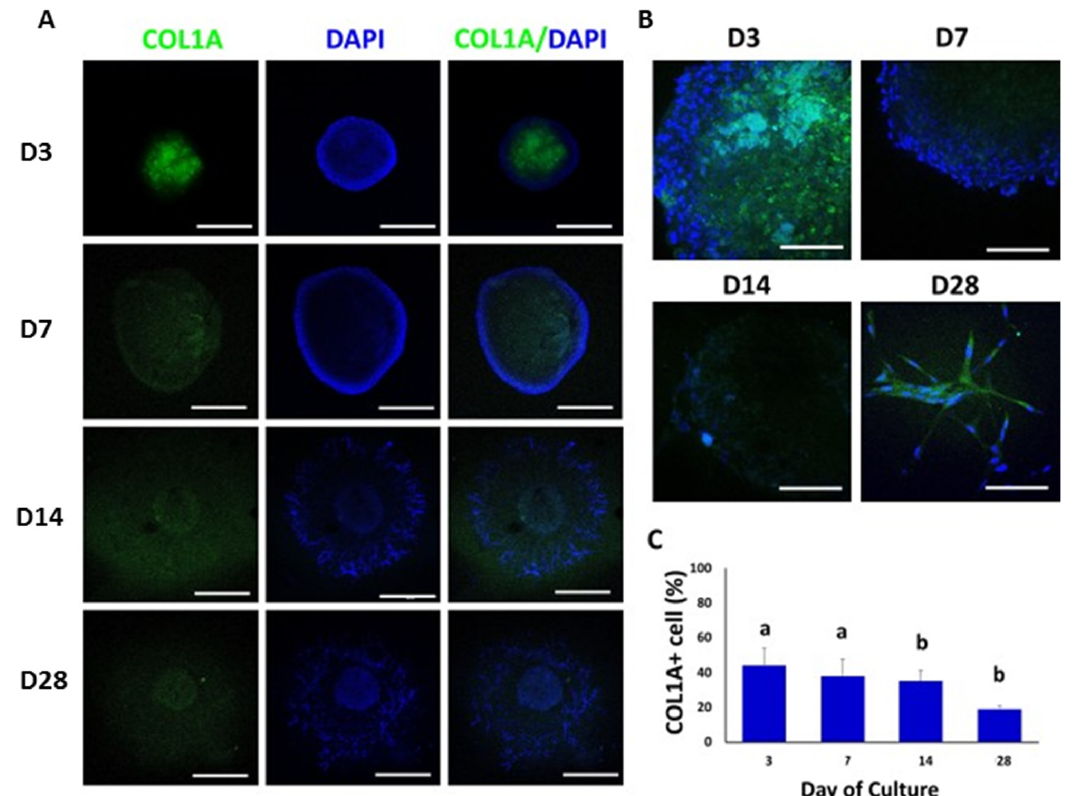
Figure 6 . Confocal immunofluorescence analysis of COL1A expression in whole mounted bovine TOs. ( A , B ) Immunofluorescence associated with COL1A was observed in whole TOs ( A ) and specific areas ( B ). ( C ) The percentage of COL1A-positive cells decreased ( p < 0.05) on days 14 and 28 compared to days 3 and 7. Data were expressed as the mean ± SEM ( n = 3). Cell nuclei were stained blue with DAPI. Scale bars = 500 μ m ( A ) and 25 μ m ( B ). Superscripts (a,b) indicate significant ( p < 0.05) differences in proportions of cells positive for COL1A between days of culture.